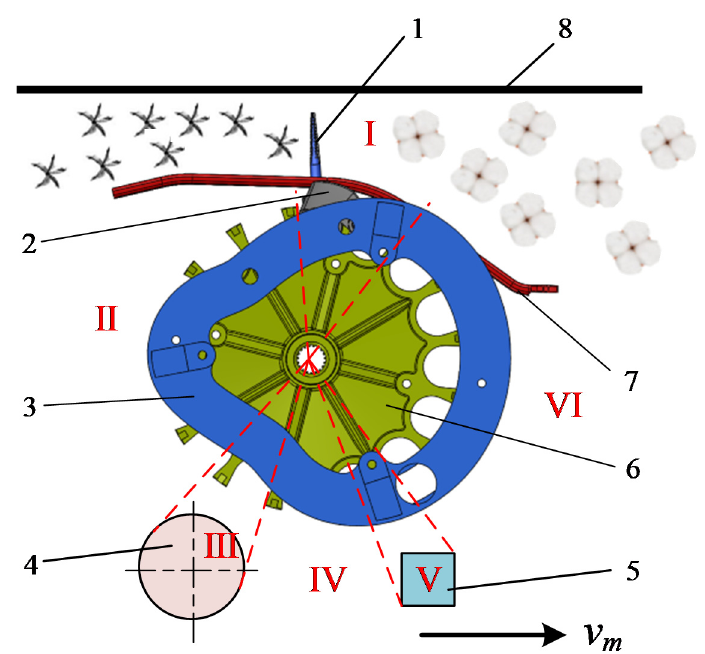
Figure 1. Schematic diagram of the working principle of the picking head (note: the consisting parts are as follows, 1. spindle, 2. crank, 3. groove cam, 4. doffer disk, 5. moistening device, 6. picking roller, 7. grid plate, 8. pressure plate; the factor v m represents the forward speed of the cotton picker, and n denotes the speed of the picking drum).